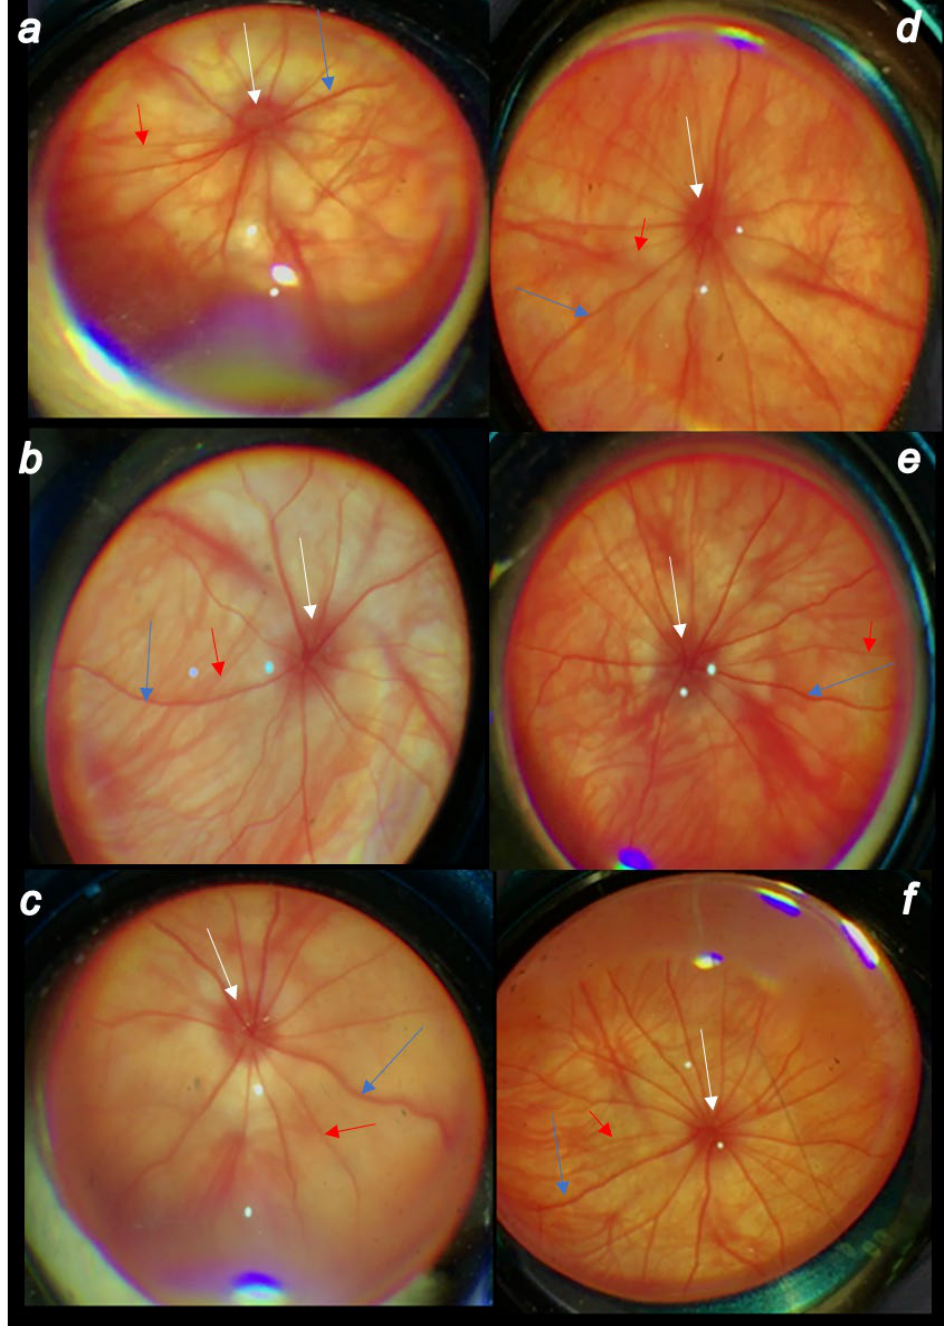
Figure 6. Cauterization of the three episcleral veins induced posterior eye segment changes (veins (blue arrows), arteries (red arrows), optic disc (white arrows)) assessed by fundoscopy. Therapeutic regimen. ( a ). First post-injury day, regular course. ( b ). Fourth post-operative week, regular course. ( c ). Sixth post-injury week, regular course. ( d ). First post-injury day, course in BPC 157-treated rats. ( b ). Fourth post-operative week in BPC 157-treated rats. ( c ). Sixth post-injury week in BPC 157- treated rats. There were the discrete generalized irregularity in the diameter of the retinal vessels with mild atrophy of the optic disc, less visible normal presentation of the choroidal blood vessels at first post-injury day ( a ), progressively leading to evident worsening at the fourth post-operative week ( b ) with the strong generalized irregularity of the diameter of the blood vessels with severe atrophy of the optic disc and barely visible (extremely faint presentation) choroidal blood vessels